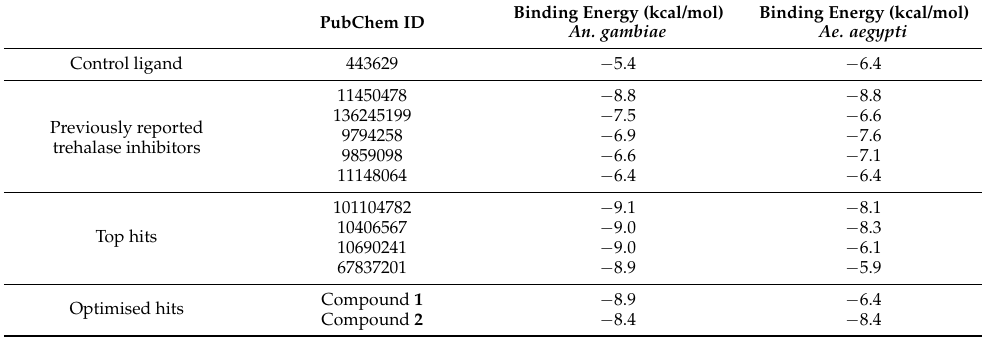
Table 6. Binding energies of compounds docked against trehalase of An. gambiae and Ae. aegypti . PubChem ID Binding Energy (kcal/mol) An.